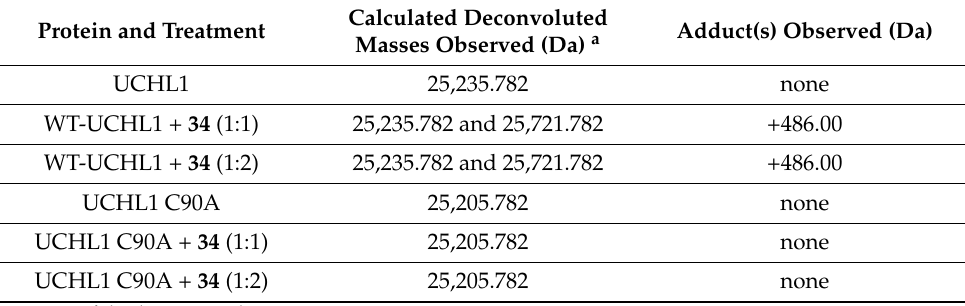
Table 2. Observed deconvoluted masses for recombinant WT- and C90A-UCHL1 treated with 34 . Calculated Deconvoluted Adduct(s) Observed (Da) Protein and Treatment Masses Observed (Da) a UCHL1 25,235.782 none WT-UCHL1 + 34 (1:1) 25,235.782 and 25,721.782 +486.00 WT-UCHL1 + 34 (1:2) 25,235.782 and 25,721.782